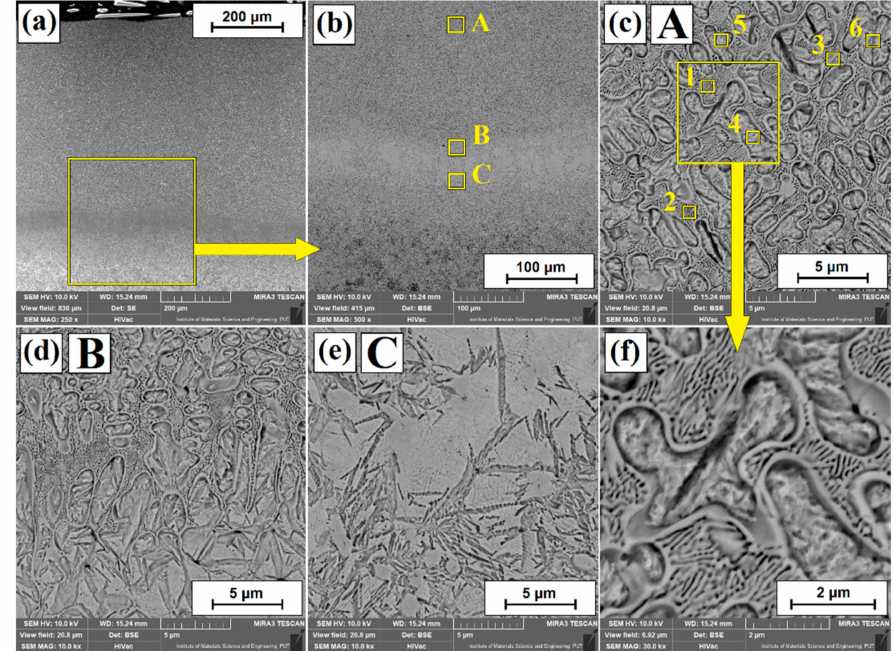
Figure 5. Microstructure of B-Cr coatings obtained using laser processing by laser beam power of 1200 W: laser tracks ( a ), enlarging the laser track ( b ), remelted zone ( c ), boundary between the remelted zone and the heat-affected zone ( d ), enlarging of heat-affected zone ( e ), and enlarging area of remelted zone ( f